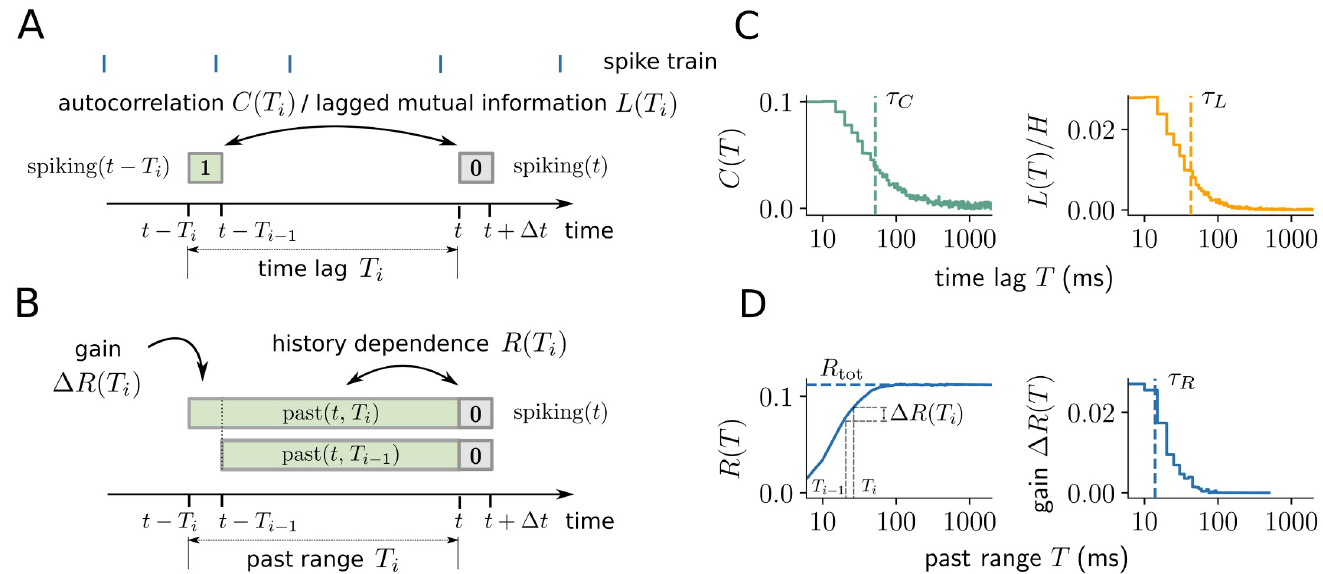
Fig 1. Illustration of history dependence and related measures in a neural spike train. (A) For the analysis, spiking is represented by 0 or 1 in a small time bin Δ t (grey box). Autocorrelation C ( T i ) or the lagged mutual information L ( T i ) quantify the statistical dependence of spiking on past spiking in a single past bin with time lag T (green box). (B) In contrast, history dependence R ( T ) quantifies the dependence of spiking on the entire spiking history in a past range T . The gain in history i i i dependence Δ R ( T i ) = R ( T i ) − R ( T i − 1 ) quantifies the increase in history dependence by increasing the past range from T i − 1 to T i , and is defined in analogy to the lagged measures. (C) Autocorrelation C ( T ) and lagged mutual information L ( T ) for a typical example neuron (mouse, primary visual cortex). Both measures decay with increasing T , where L ( T ) decays slightly faster due to the non-linearity of the mutual information. Timescales τ C and τ L (vertical dashed lines) can be computed either by fitting an exponential decay (autocorrelation) or by using the generalized timescale (lagged mutual information). (D) In contrast, history dependence R ( T ) increases monotonically for systematically increasing past range T , until it saturates at the total history dependence R tot . From R ( T ), the gain Δ R ( T i ) can be computed between increasing past ranges T i − 1 and T i (grey dashed lines). The gain Δ R ( T ) decays to zero like the time-lagged measures, with information timescale τ R (dashed line).